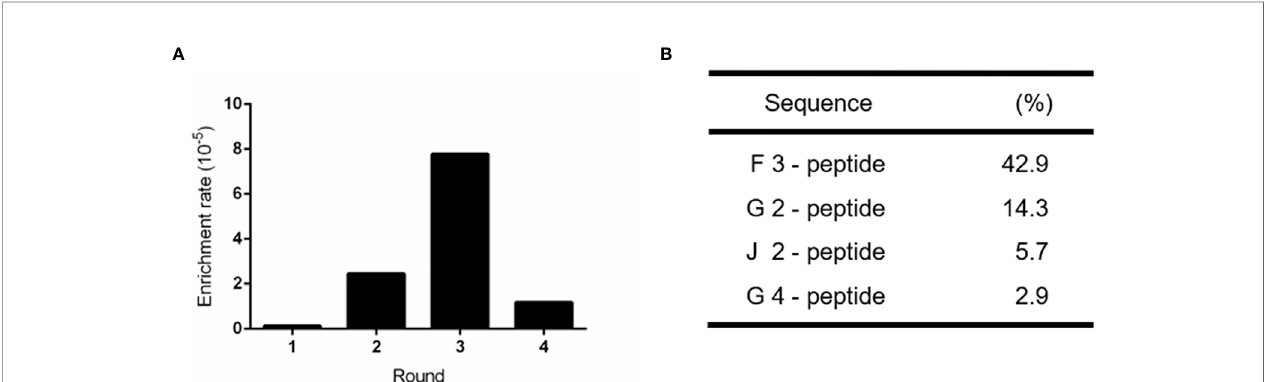
FIGURE 1 | Enrichment of positive phage clones speci fi cally binding to the recombinant human GPC-3 protein. (A) Bio-panning via a M13 phage-displayed C7C peptide library on the immobilized GPC-3 protein resulted in ~50-fold enrichment in the Round 3 of selection. (B) Highly repeated peptide sequences were obtained from the third round of bio-panned phages. 93 individual phage clones were randomly selected for sequencing after the third round of screening. The proportion of each positive peptide was